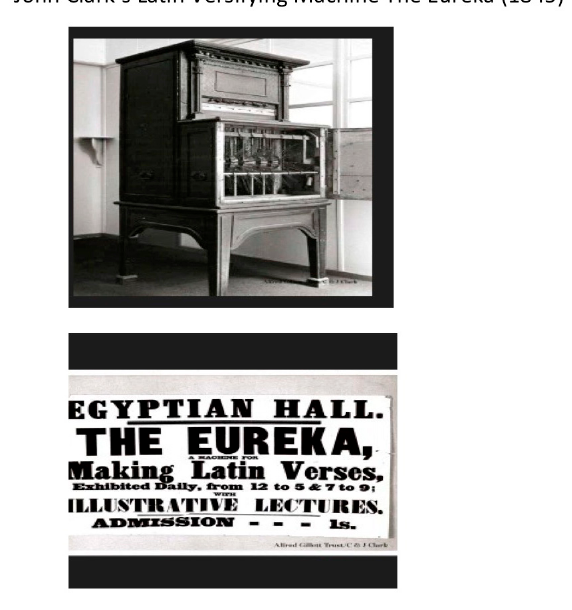
Figure 9. John Clark’s Latin versifying machine, The Eureka ( top ) and an entry ticket ( below ) to the machine’s exhibition at the Egyptian Hall, Piccadilly (Alfred Gillett Trust).